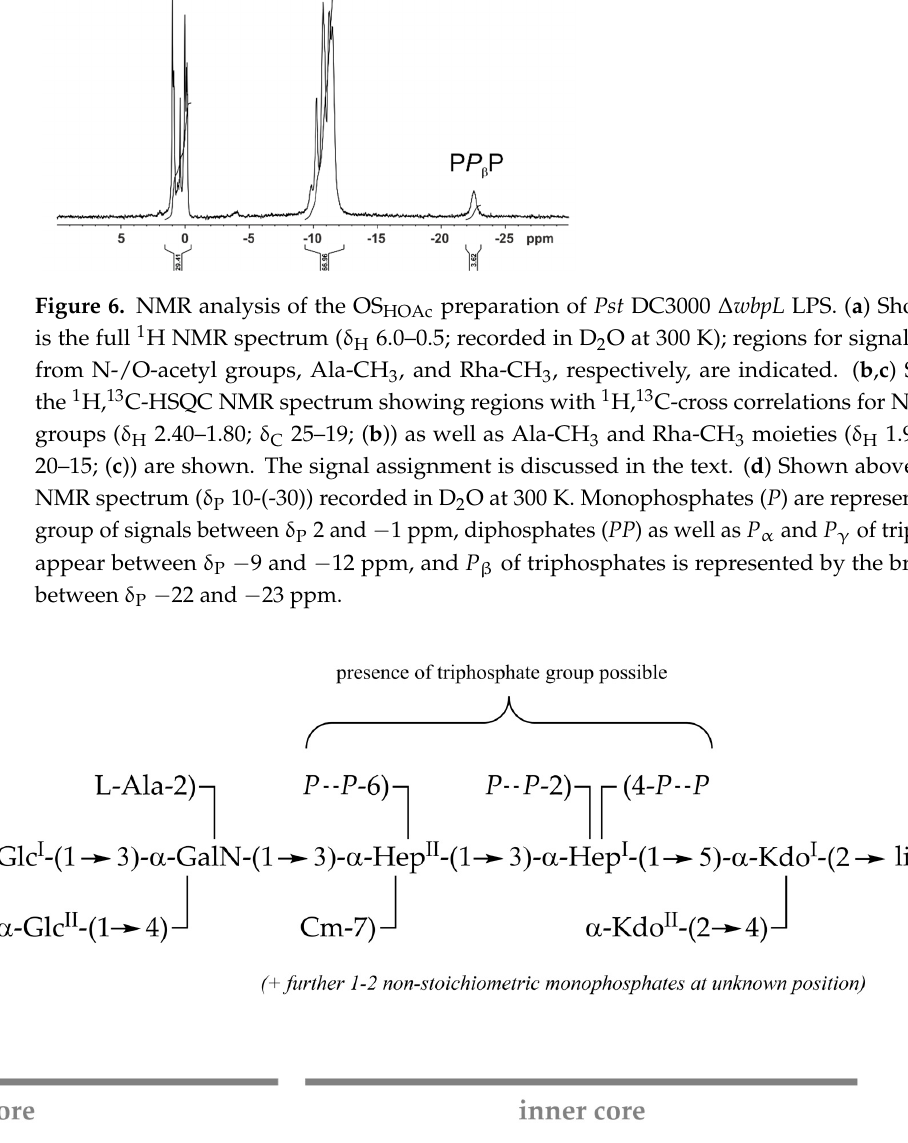
Figure 7. Scheme of the core-OS of Pst DC3000 LPS. It has the same basic structure as the core-OS identified in P. syringae pv. phaseolicola (glycoform 1) [26], but for Pst DC3000 core-OS the observed degree of phosphorylation is significantly higher. Position 2 and 4 of Hep I or position 6 of Hep II are occupied by a diphosphate group in a significant proportion (dashed lines indicate nonstoichiometric substitution) and further nonstoichiometric monophosphates at so far unknown positions can be present. To a lesser extent, triphosphate groups are present as well. The terminal Rha moiety is O-acetylated with up to two acetyl groups.